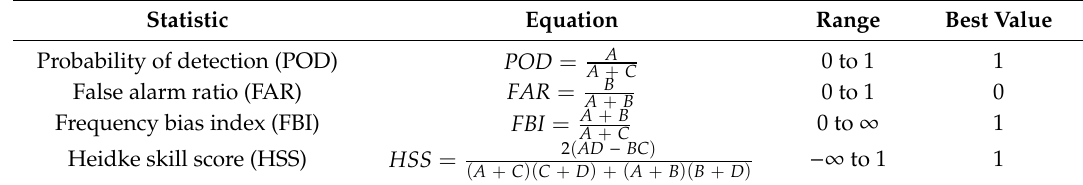
Table 2. Statistical formulas to rainfall detection capabilities of CHIRPS based on categorical metrics, where: A, B, C and D represent hits, false alarms, misses and correct negatives, respectively (Table 1). Statistic Equation Range Best Value Probability of detection (POD) POD = A A + C